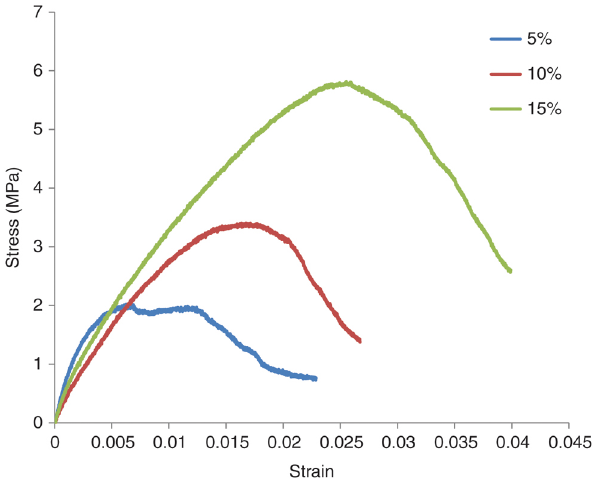
Figure 6: Stress-strain curve for samples prepared at 60°C temperature and 70 bar pressure.